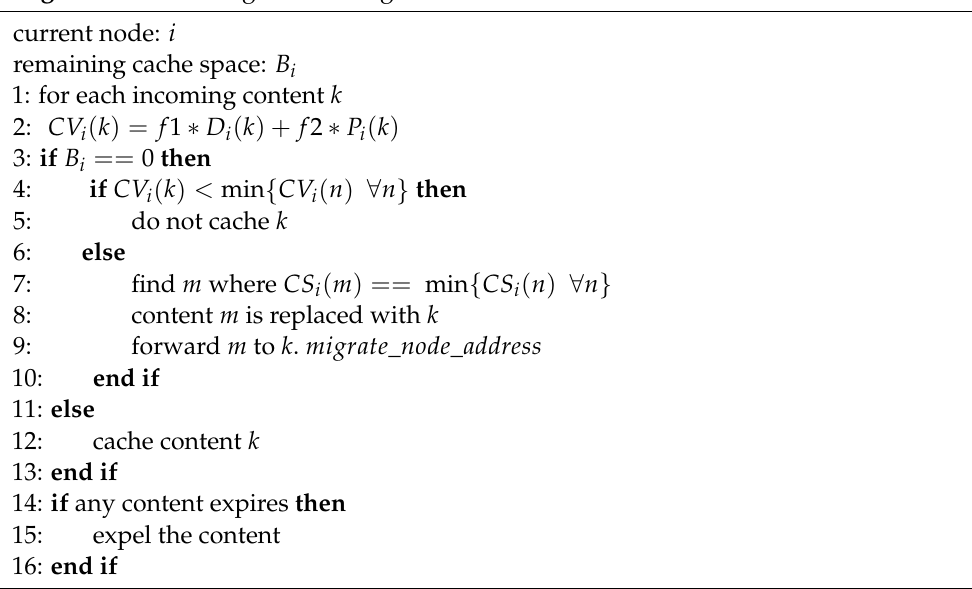
Algorithm 1: Caching in User-Edge